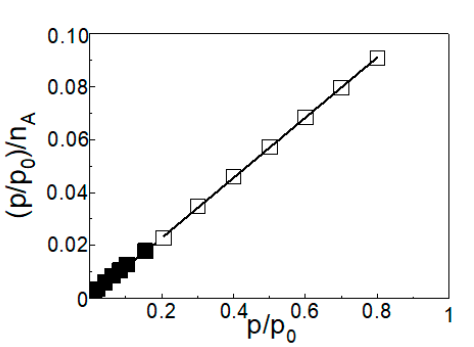
Figure 5. Linearized Langmuir adsorption isotherm of cyclohexane on CBa at 30 ◦ C. Solid points are up to the relative pressure p / p 0 of 0.2, open points are over the relative pressure p / p 0 of 0.2. The monolayer capacity of the adsorbent (n m ), the constant related to the energy of adsorption (K), and the coe ffi cient of determination (R 2 ) were calculated and can be seen in Table 4. Linearized data up to the relative pressure value p / p 0 of 0.2 are plotted as a solid point, data above the relative pressure value p / p 0 of 0.2 are plotted as an open point.